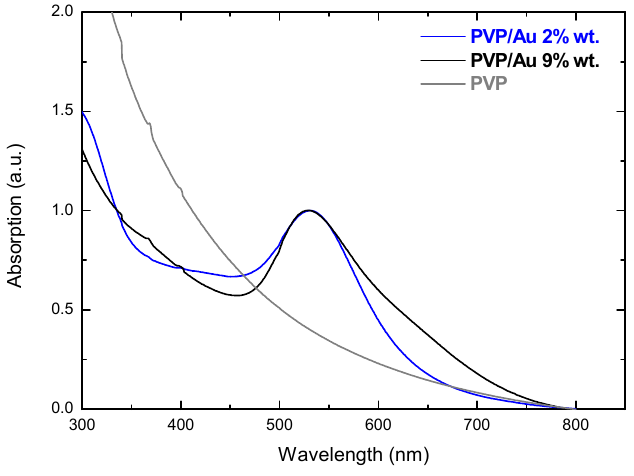
Figure 2. UV-vis spectra of the pristine PVP and PVP/Au colloidal solutions prepared in MeOH, with 2% and 9% wt. Au nanoparticles (NP) loading.